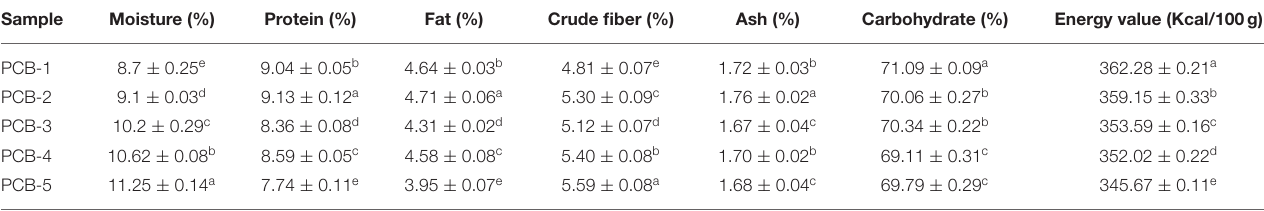
TABLE 3 | Nutritional values of developed PCB. Sample Moisture (%) Protein (%) Fat (%) Crude fiber (%) Ash (%) Carbohydrate (%)